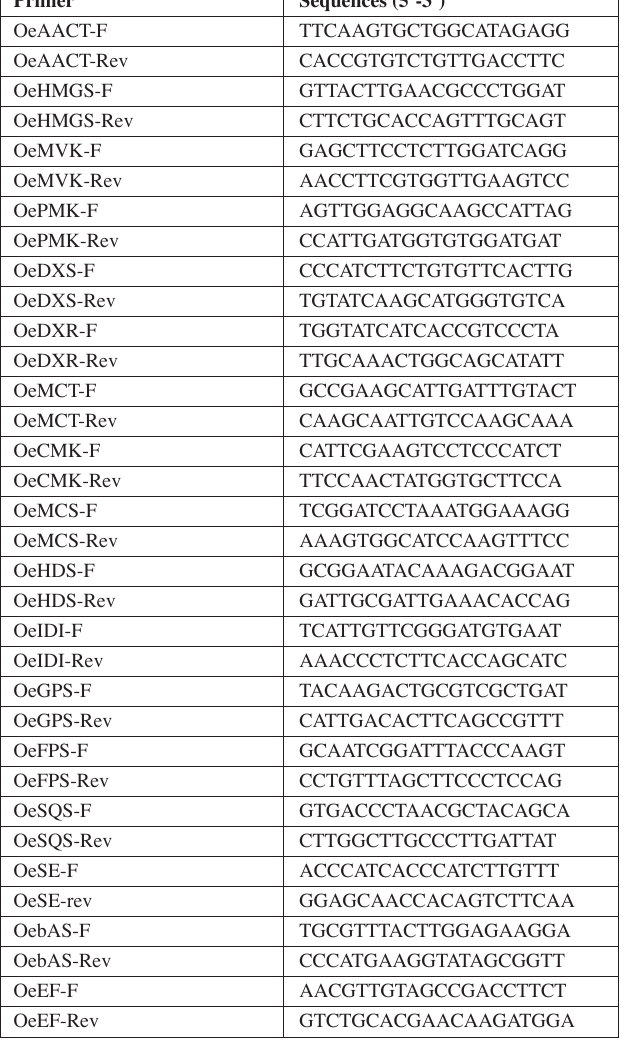
Tab. S2: Top BLAST hits in the NCBI NR database. BLAST results with respect to the NCBI NR database for all distinct sequences with a cutoff E-value greater than 10 -5 are